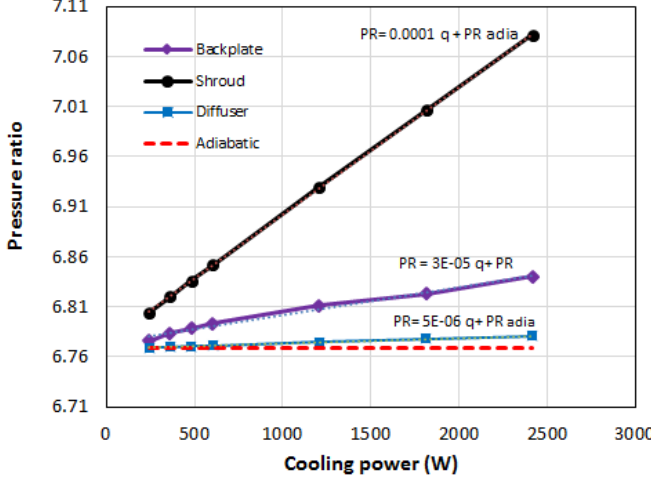
Figure 6 . Effect of cooling on different walls with varied cooling power on the total pressure ratio.